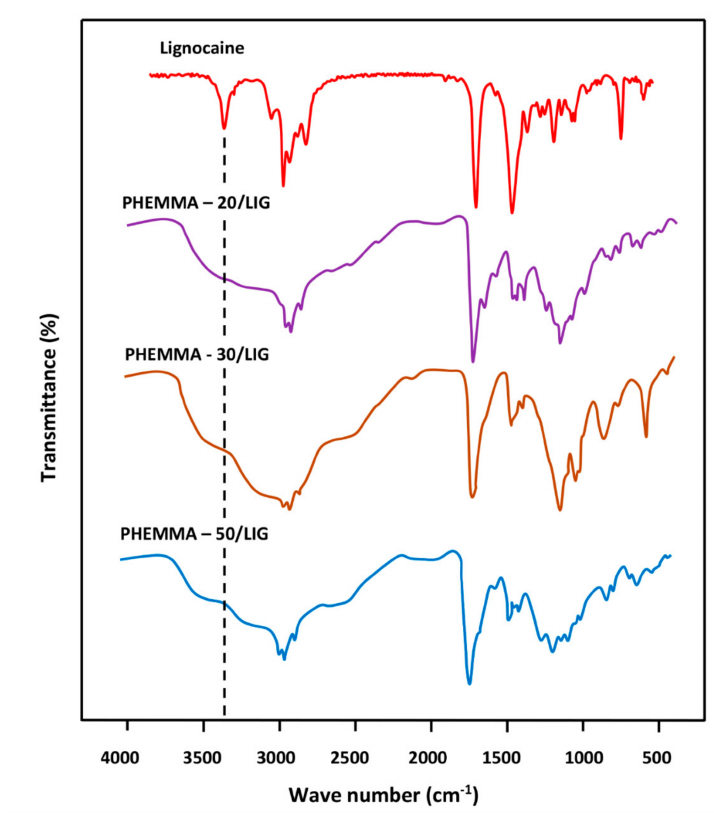
Figure 5. FTIR analysis of LIG, virgin PHEMMA, and PHEMMA / LIG systems with different MMA contents.